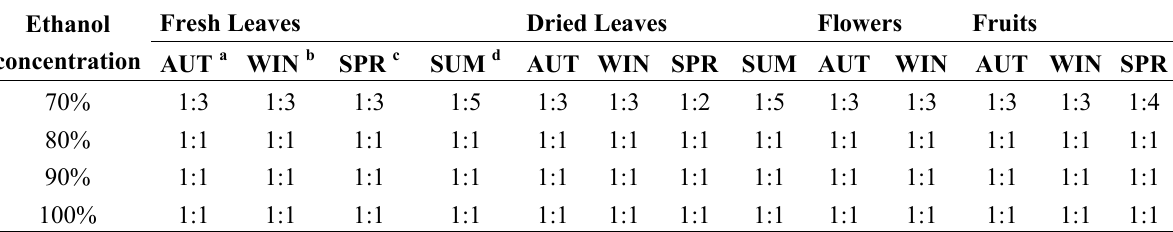
Table 2. Solubility in ethanol of essential oils from plant organs of E. cinerea . Fresh Leaves Dried Ethanol concentration